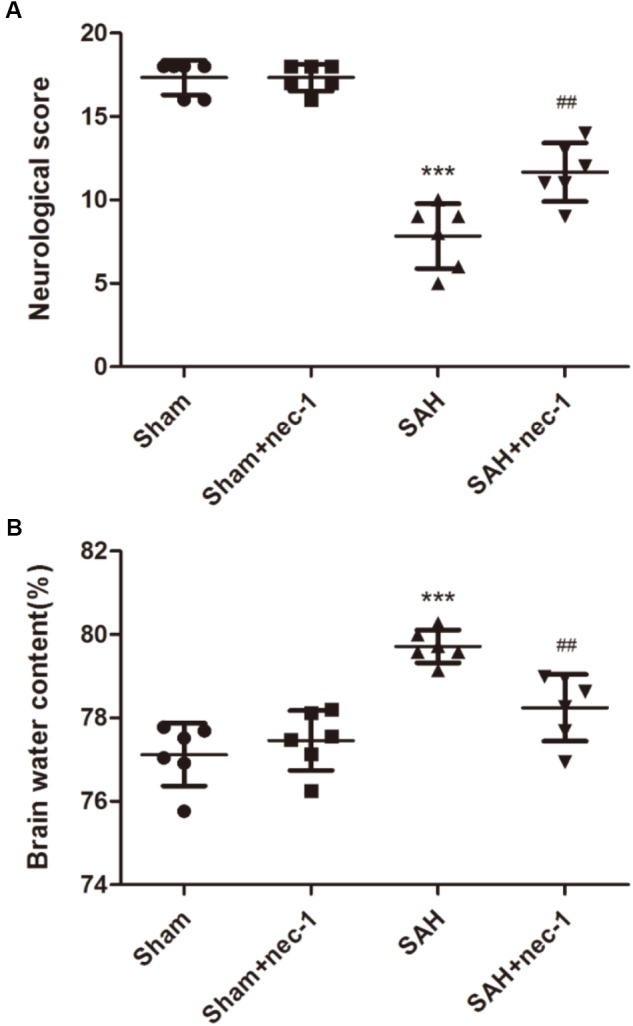
Specific necroptosis inhibitor improves neurobehavior scores and brain edema. (A) Compared with the Sham and Sham+nec-1 groups, the SAH group showed a lower neurobehavior score. In the Sham+nec-1 group, the injection of nec-1 significantly improved neurobehavior scores after SAH. ∗∗∗P < 0.001, Sham vs. SAH, ##P < 0.01, SAH+nec-1 vs. SAH. (B) Brain water content showed an obvious increase after SAH compared with the Sham group. However, nec-1 can effectively inhibit brain edema after SAH. ∗∗∗P < 0.001, Sham vs. SAH, ##P < 0.01, SAH+nec-1 vs. SAH.